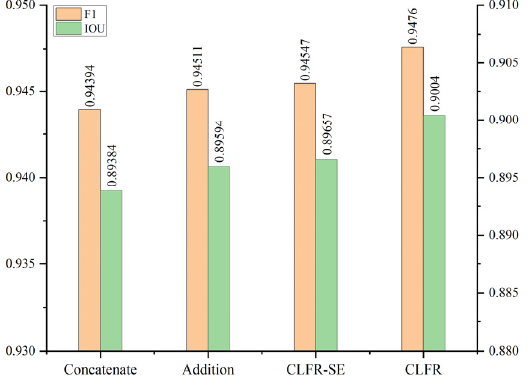
Figure 15. F1 scores and IOU of different cross level feature fusion schemes on the WHU building dataset.